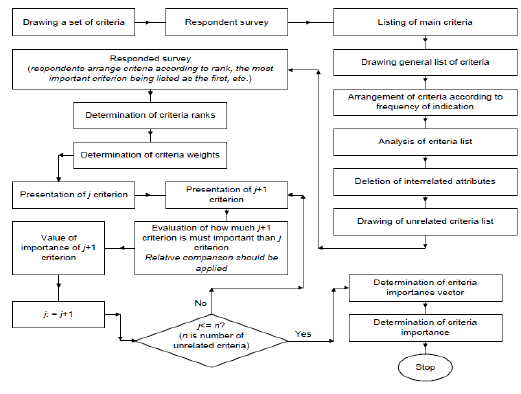
Figure 3. The Framework of Determining